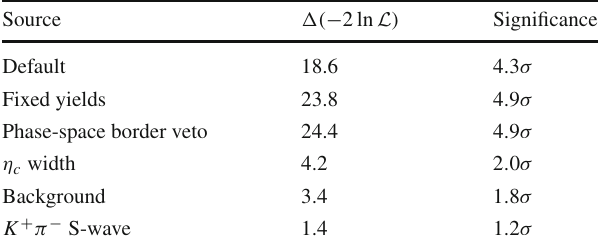
Table 6 Rejection level of the J P = 0 + hypothesis with respect to the J P = 1 − hypothesis for the systematic variations producing the largest variations in the parameters of the Z c ( 4100 ) − candidate. The values obtained in the nominal amplitude fit are shown in the first row